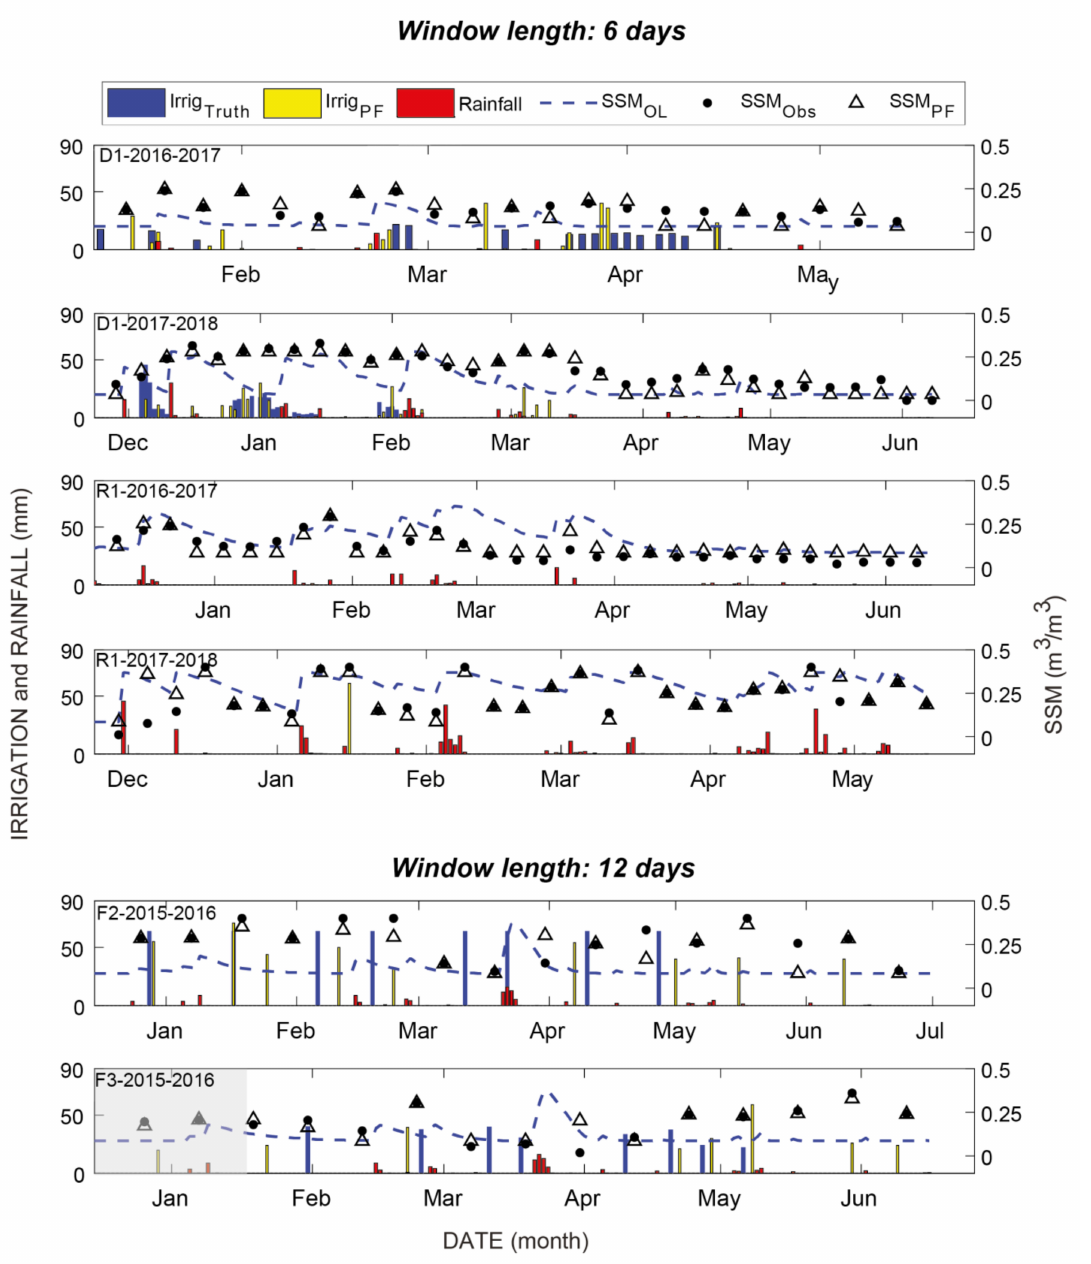
Figure 6. Time series of the daily estimated irrigation (Irrig PF ), the actual irrigation (Irrig Truth ) and measured rainfall. Time series of the assimilated (SSM PF ), S1–derived (SSM obs ) and the open loop (SSM OL ) SSM over the drip-irrigated (D1) and rainfed (R1) field for both seasons 2016–2017 and 2017–2018 for a window length of 6 days and the flood-irrigated fields F2 and F3 during 2015–2016 season at 12-day window